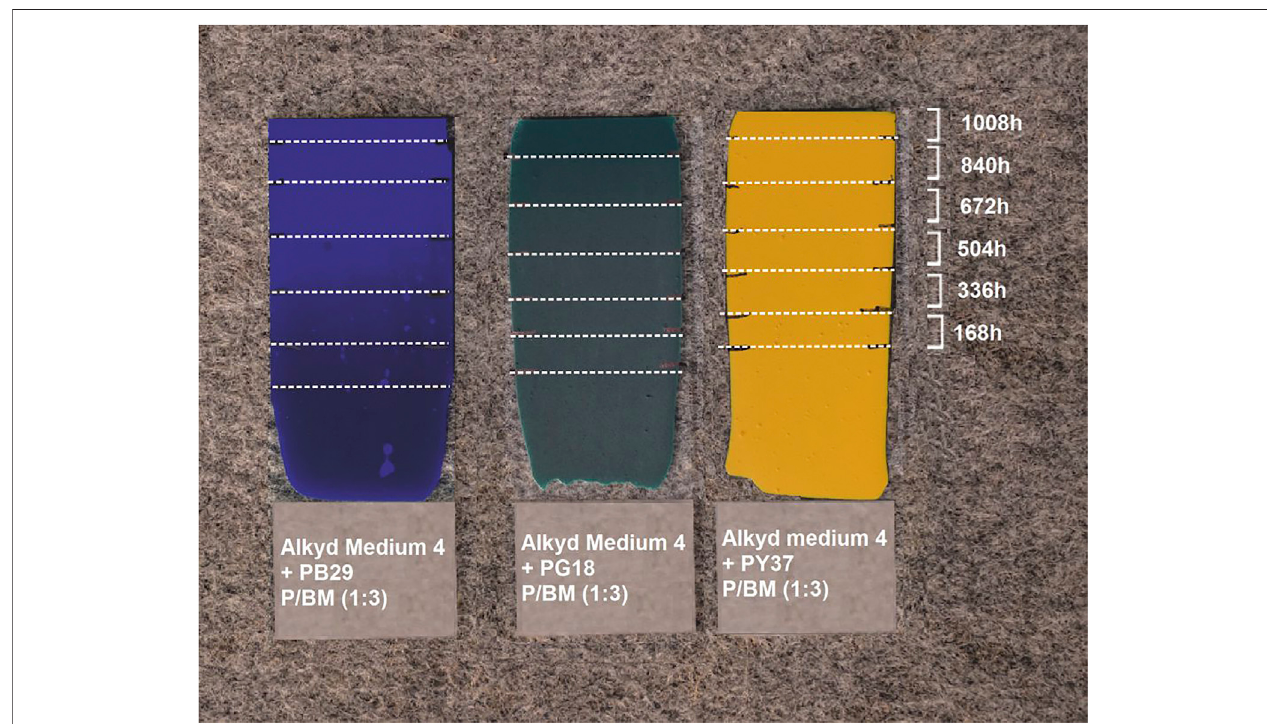
FIGURE1| Three paint sampleswithP/BM ratio1:3; from leftAlkyd Medium 4+PB29,Alkyd Medium 4+PG18, Alkyd Medium 4 +PY37. They were exposed to arti fi cial sunlight for 168, 336, 504, 672, 840, and 1,008 h.